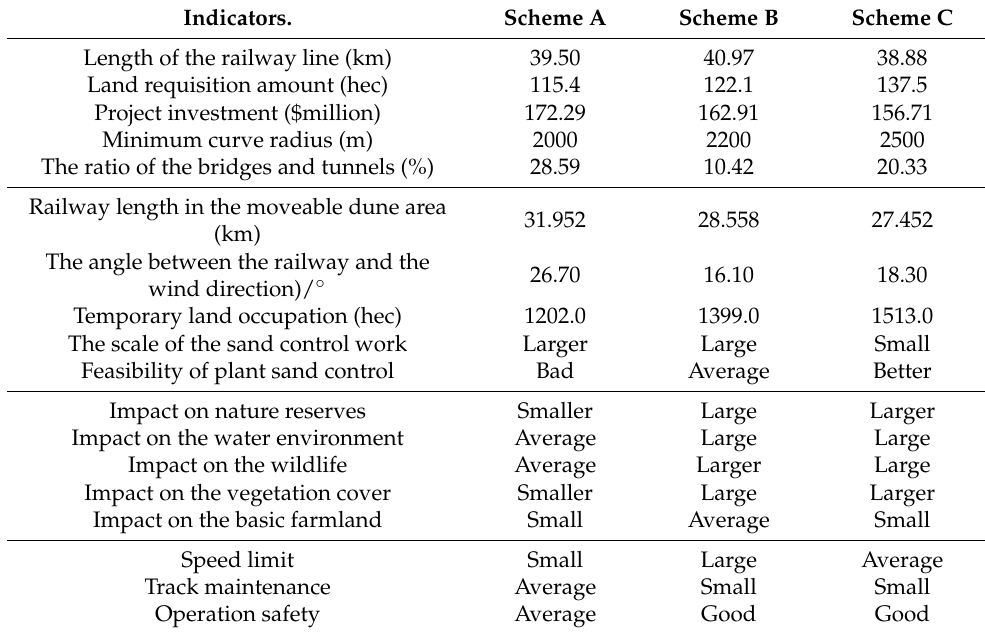
Table 3. Engineering information of route schemes. Indicators. Scheme A Scheme